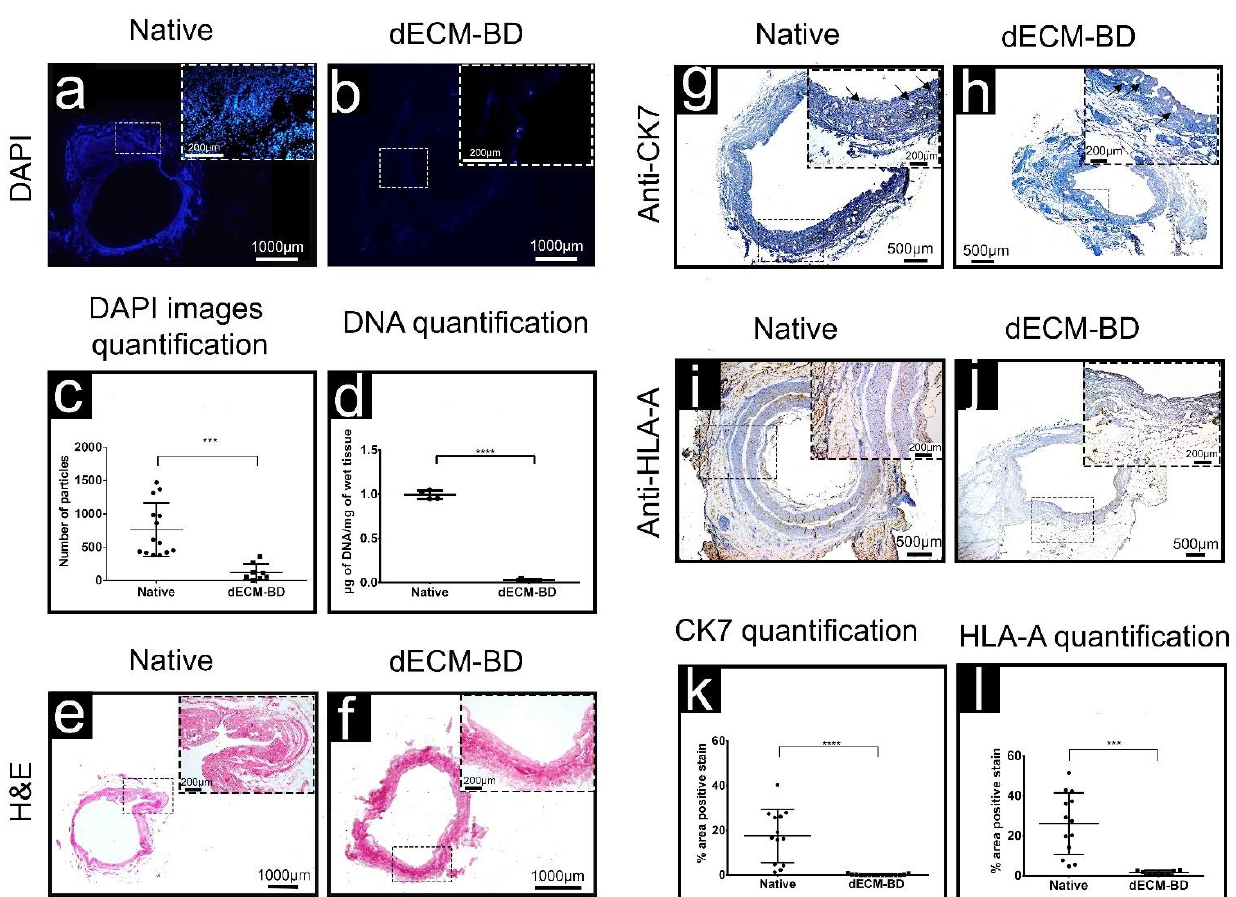
Figure 2. Decellularization assessment. The spatial DAPI nuclei labeling comparison of native bile duct ( a ) and decellularized (dECM-BD) ( b ). Quantification of DAPI images showed a significant decrease of positively stained particles (i.e., nuclei) in the dECM-BD samples ( c ). The quantification of residual DNA confirmed the decrease of DNA content in dECM-BD samples, and **** p < 0.05 is considered significant. Data are expressed as the mean ± SD (n = 9) ( d ). H&E stains confirmed the removal of cells ( e , f ). The comparison of the native and decellularized bile ducts by immunohistochemistry of anti-CK7 ( g , h ), and anti-human leukocyte antigens (anti-HLA-A) ( i , j ) showed the decrease of these cells’ proteins in the decellularized samples ( h , j ). The positive labeling of CK7 cell protein is observed in the submucosa region of the native bile duct ( g ), and the dECM-BD show the elimination of CK7 ( h ). The arrows indicate the lumen conservation of the vascular plexus after the decellularization process ( g , h ). Quantification of anti-CK7 ( k ) and anti-HLA-A ( l ) from the immunohistochemistry images showing a significant difference between native and dECM-BD; **** p < 0.05 and *** p < 0.05 were considered significant from CK7 and HLA-A, respectively. Data are expressed as the mean ±SD (n = 9).